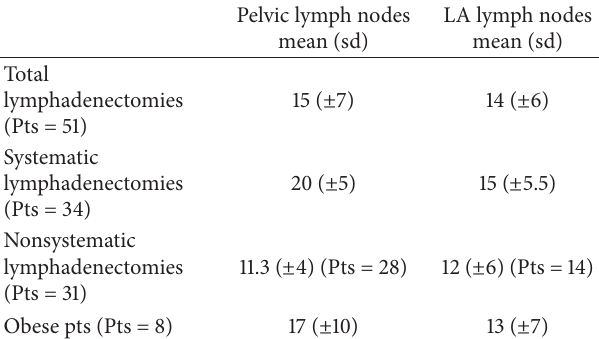
Table 3: Mean number of lymph nodes in different groups.